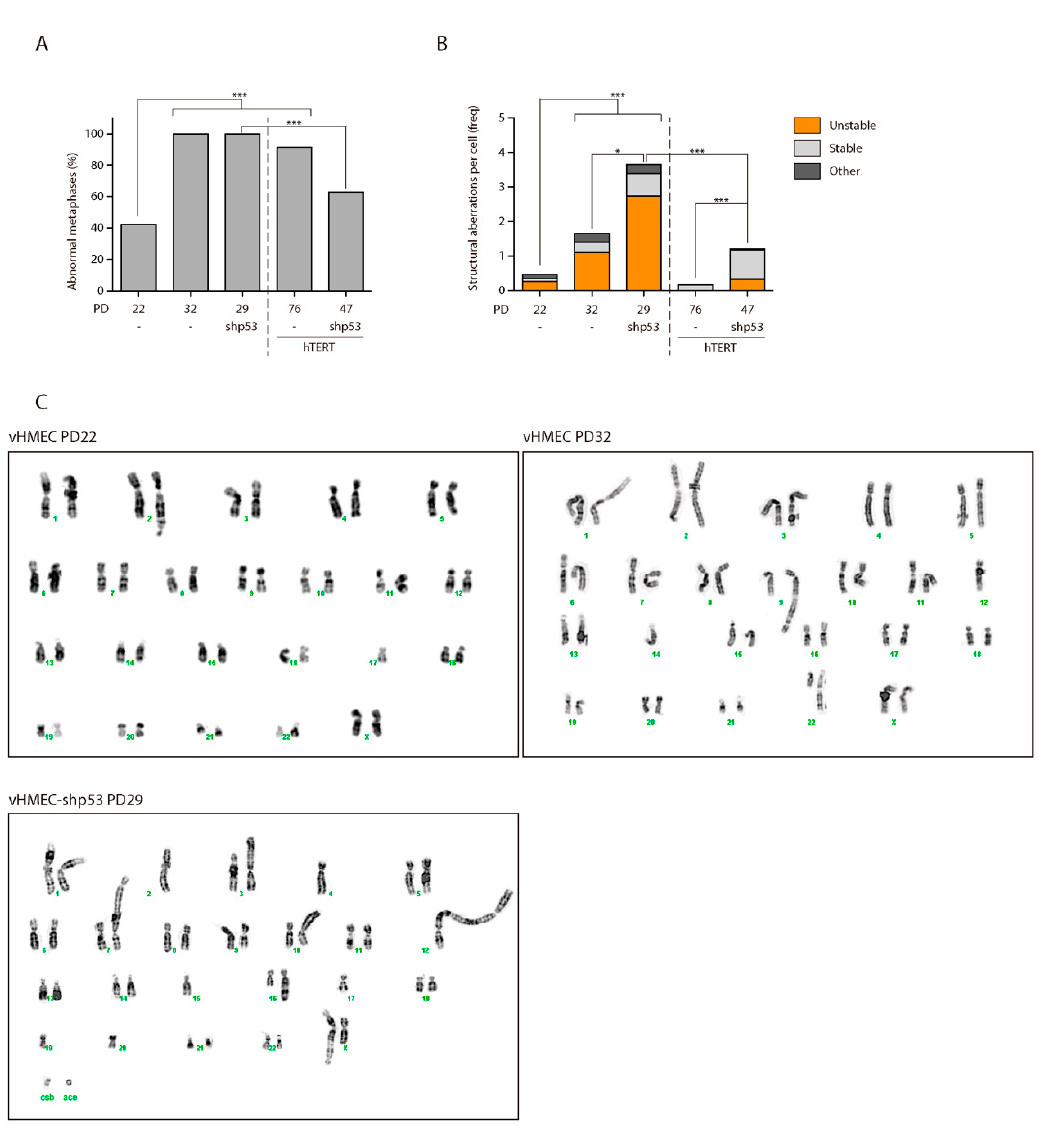
Figure 3. Cytogenetic analysis of the different cell lines. ( A ) Graph displaying the contribution of the telomere status and p53 functionality in the presence of abnormal karyotypes in vHMEC-derived cell lines. Statistical significance after Fisher’s exact test comparisons is shown. *** indicates p -values lower than 0.001; ( B ) Distribution of the different types of chromosomal structural aberrations: unstable, i.e., fusions or dicentric chromosomes and acentric fragments; stable, i.e., non-reciprocal and reciprocal translocations, isochromosomes, marker chromosomes and deletions; and other, i.e., chromosome and chromatid breaks. Statistical significance after Kruskal-Wallis test and Dunn’s multiple comparison post-test is shown. * indicates p -values lower than 0.05; *** indicates p -values lower than 0.001; ( C ) Example of finite vHMEC karyotypes. At PD22, young vHMECs show 45, XX, fus (2q;17q); at PD32, aged vHMECs show 45, XX, fus (9q;12q), nrt (22q;14q). By contrast, the karyotype of p53 compromised vHMECs demonstrates the complexity of their karyotype. At PD29, vHMEC-shp53 show 40, X, dic (2p;?;12p), nrt (3p;?), dic (4q;7p), dic (10p;?), nrt (16q;?), tetrac (17q;22;X;20p), +ace, +csb.